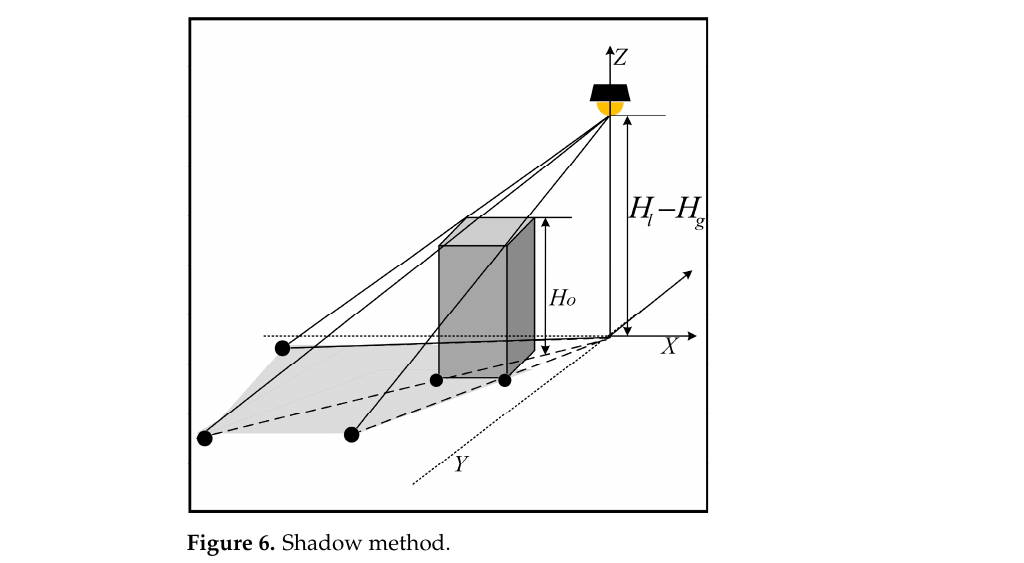
Figure 6. Shadow method.